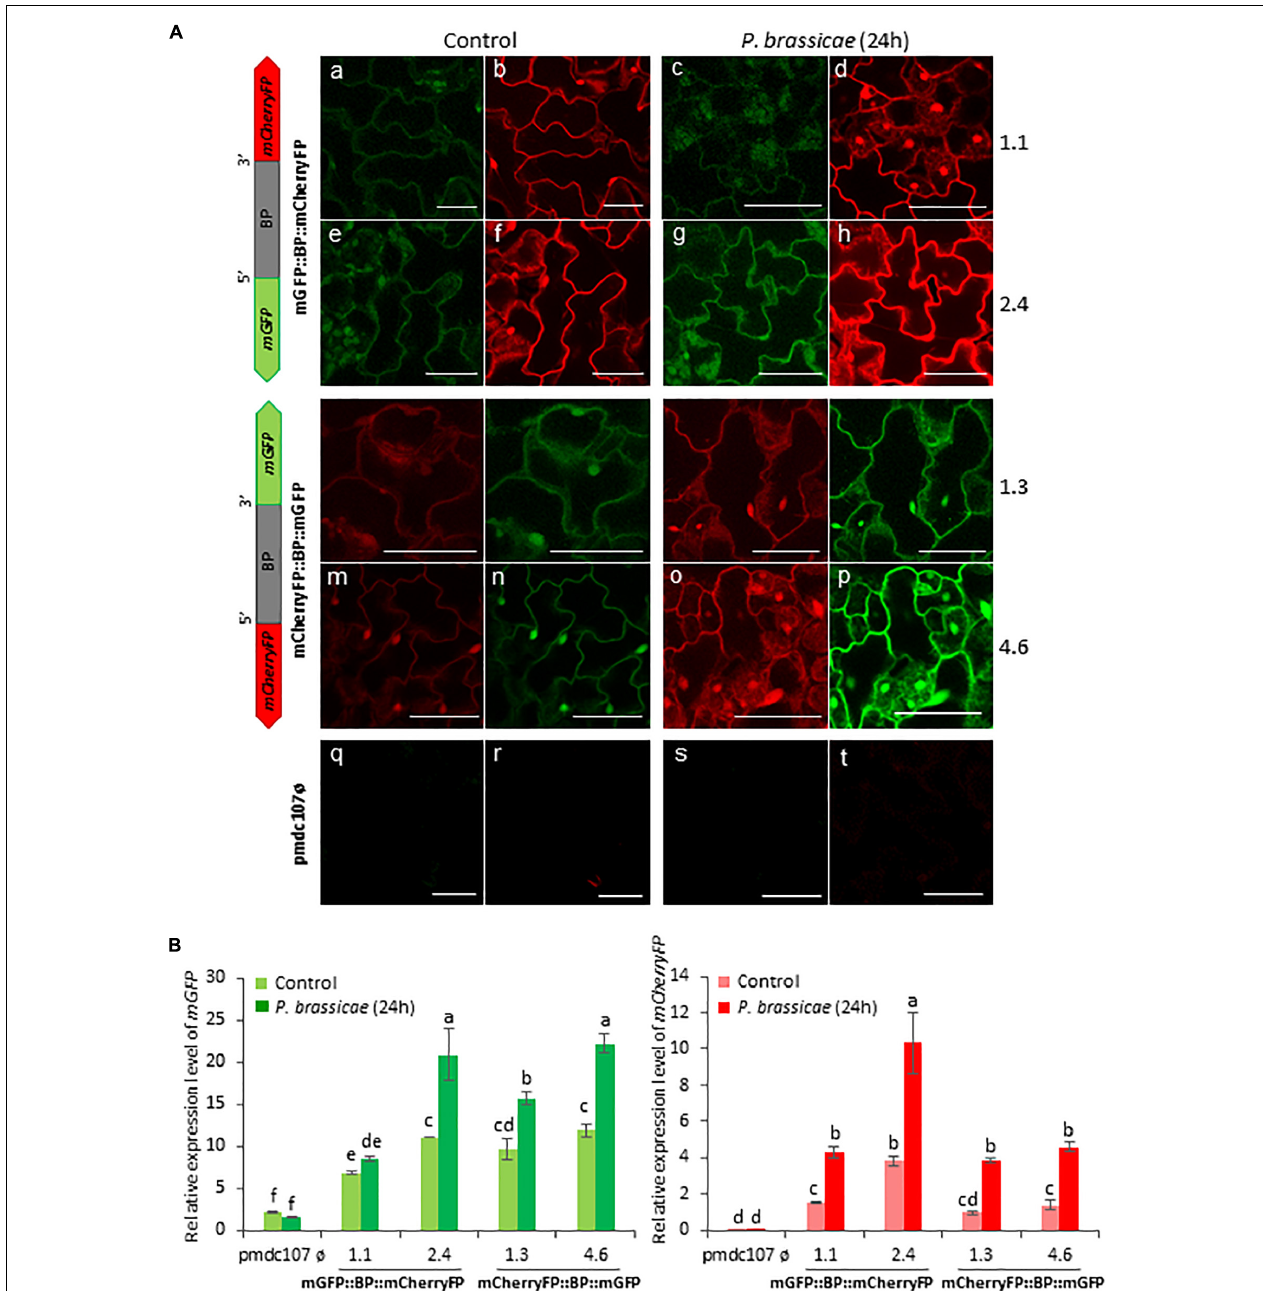
FIGURE 5 | Schematic representation of fusion-constructs and expression assays in stably transformed Arabidopsis plants in response to P. brassicae infestation. (A) Scheme of mCherryFP and mGFP genes under the bidirectional promoter (BD) and confocal stacks spanning Arabidopsis epidermal cells of transformed leaves under control conditions, and after P. brassicae infestation. Projections are from mCherryFP (b,d,f,h,i,k,m,o,r,t) and mGFP (a,c,e,g,j,l,n,p,q,s) . Bars are 50 µ m. (B) Quantitative analyses of mGFP and mCherryFP gene expression in stably transformed Arabidopsis plants in control, and after 24 h of P. brassicae infestation. Bars in green and red colors correspond to mGFP and mCherryFP gene expression, respectively. Data are ± SE of three biological replicates. Different letters indicate statistical differences ( P < 0.05 Wald χ 2 , followed by LSD test). Arabidopsis transformed lines for mGFP::BP:mCherryFP construct were 1.1, 2.4, and for mCherryFP:BP::mGFP were 1.3 and 4.6. Primers used for this experiment are listed in Supplementary Table 1